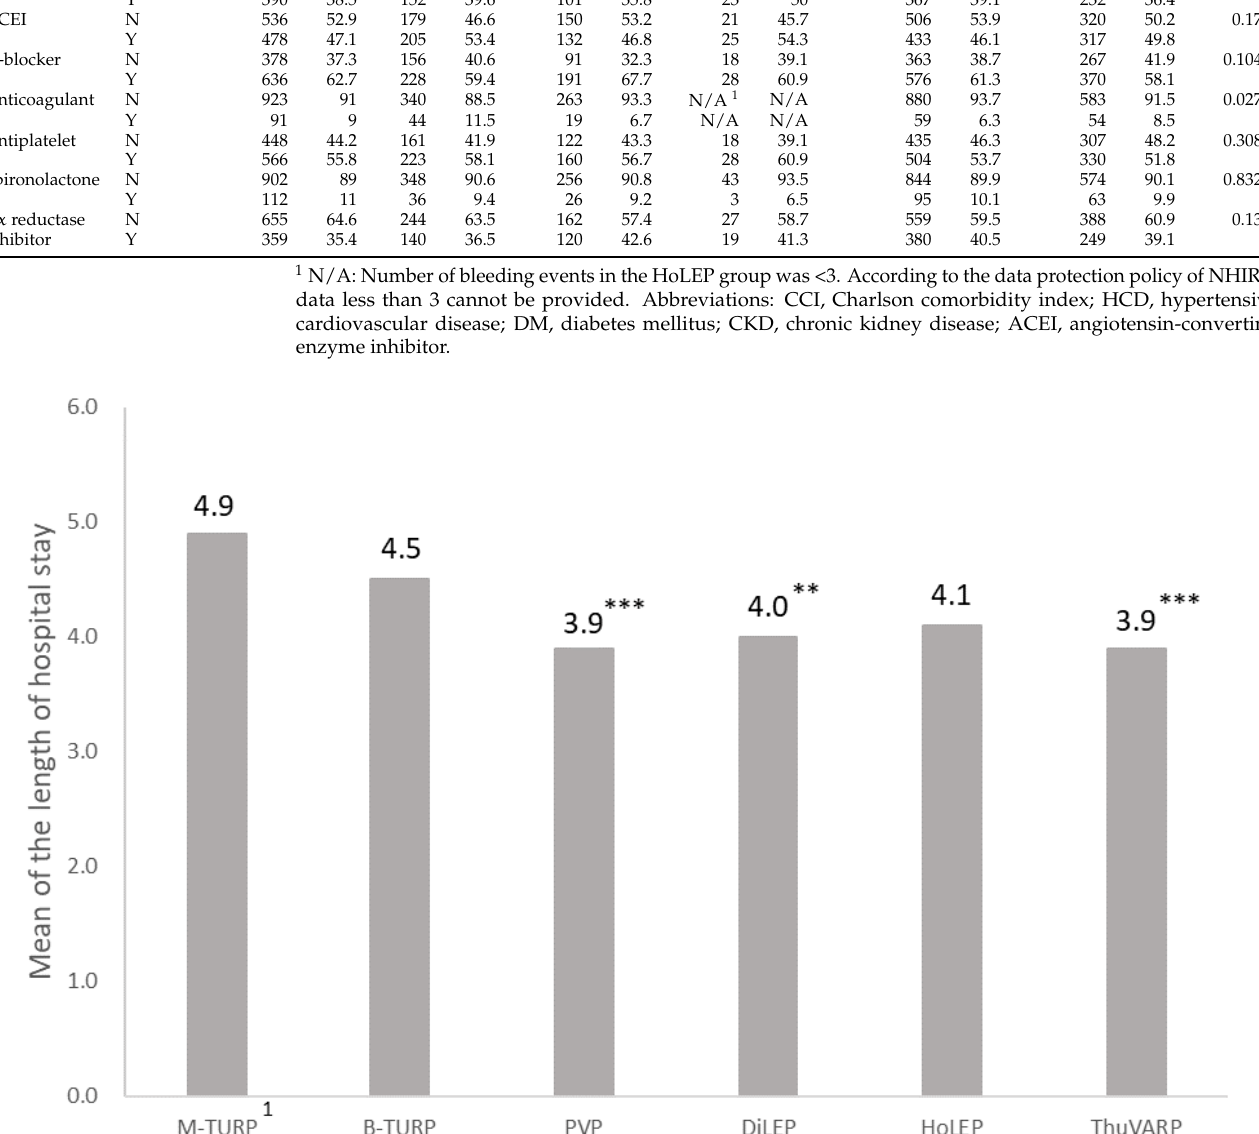
Figure 2. Average length of hospital stay following TURP and laser surgery. ** p < 0.01, and *** p < 0.001 versus M-TURP. 1 M-TURP was the reference group.